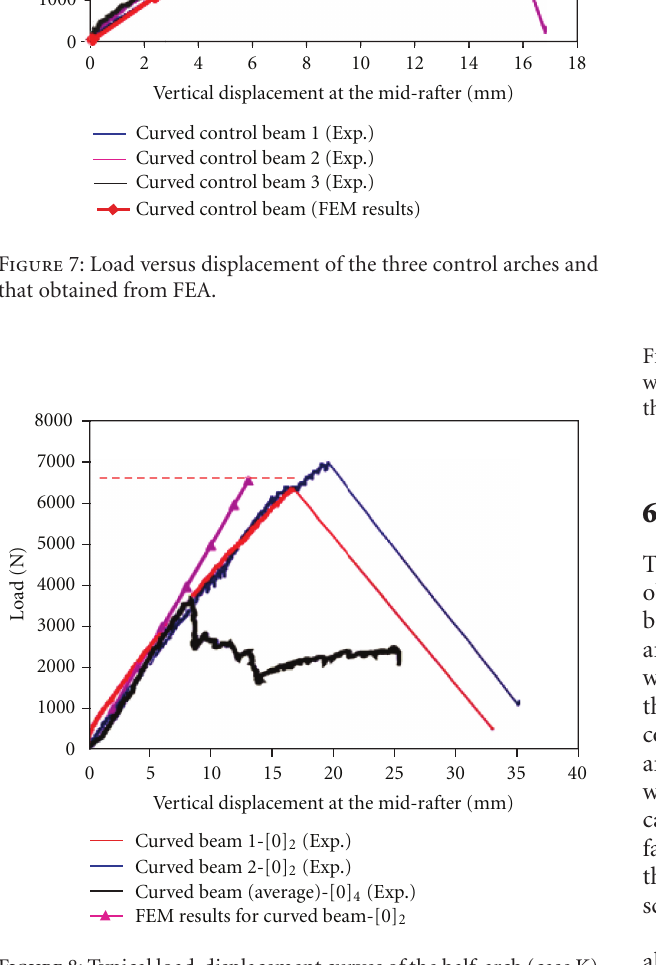
Figure 8: Typical load-displacement curves of the half-arch (case K) with two and four layers of partial reinforcement compared to the FEM results.